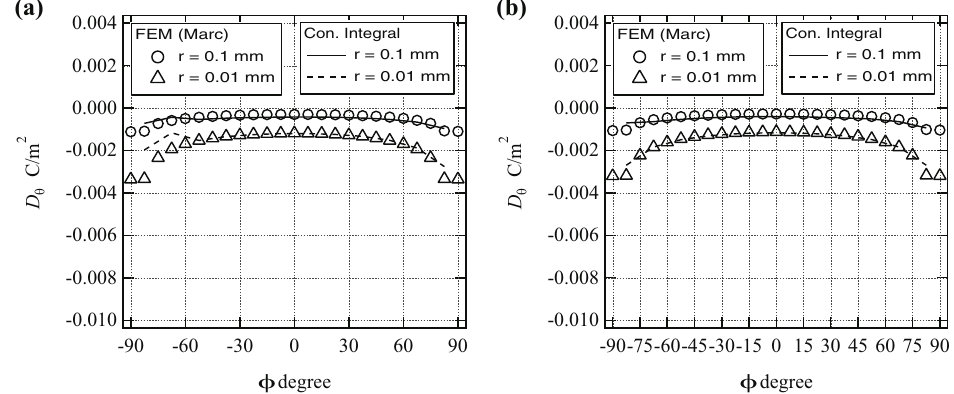
Figure 14: Distribution of electric displacements, D θ , at the interface, = θ 90° , with fi xed r at 0.01 and 0.1 mm on the singular line ( front - line at d = 3 mm ) : ( a ) Model - 1 and ( b ) Model - 2.